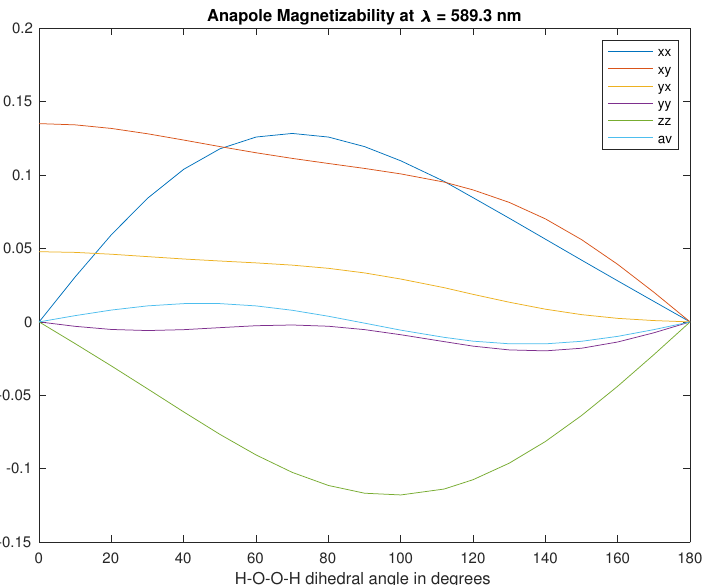
Figure 5. Tensor components of the anapole magnetizability a αβ for the R α enantiomer of the hydrogen peroxide molecule at λ = 589.3 nm, as a function of the dihedral angle.